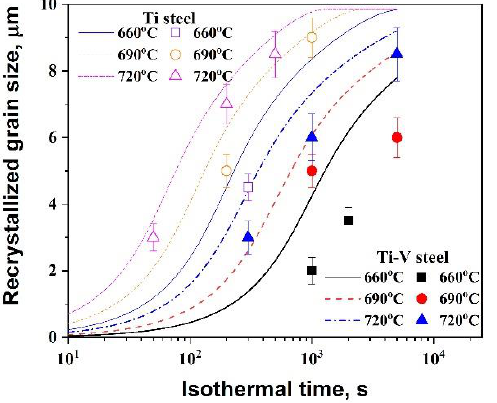
Figure 8. Comparison between calculated and measured recrystallized grain size of Ti and Ti-V steels at a series of different temperatures (660, 690, 720 °C).